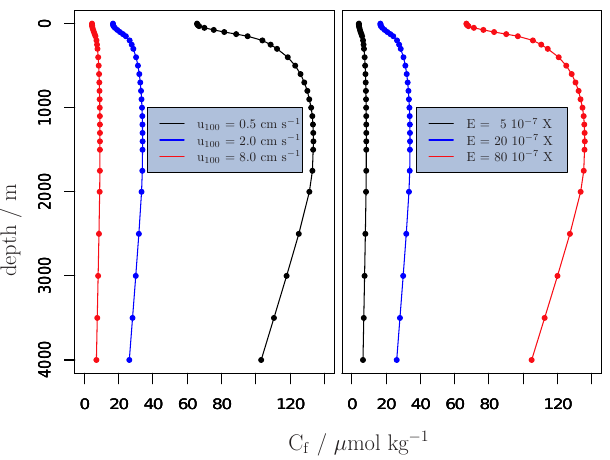
Fig. 5. The influence of flow velocity u 100 and exam- ples of given laboratory-determined oxygen uptake rates E ( X =µmols − 1 cm − 2 ), along depth profiles of temperature T , and hydrostatic pressure P at the Pacific station SC off Southern Cali- fornia (120.5 ◦ W, 29.5 ◦ N). T E =5 ◦ C, and S E